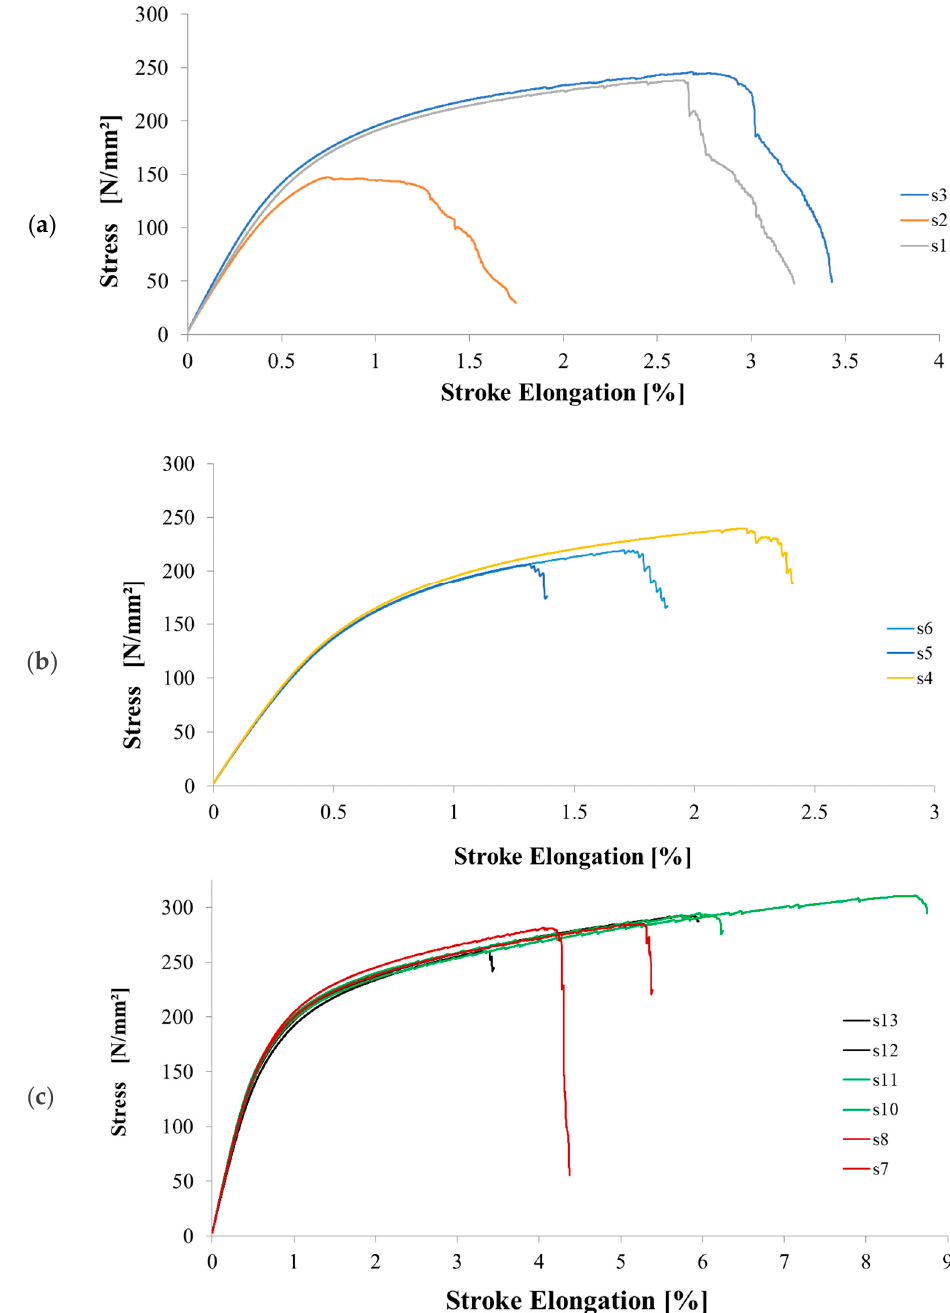
Figure 8. Tensile Test Results in 1 mm-min stroke speed of AlMgCu Alloyed ( a ) A1 alloy Set (Nb) ( b ) A2 alloy Set (Ti–V) ( c ) A3 alloy Set